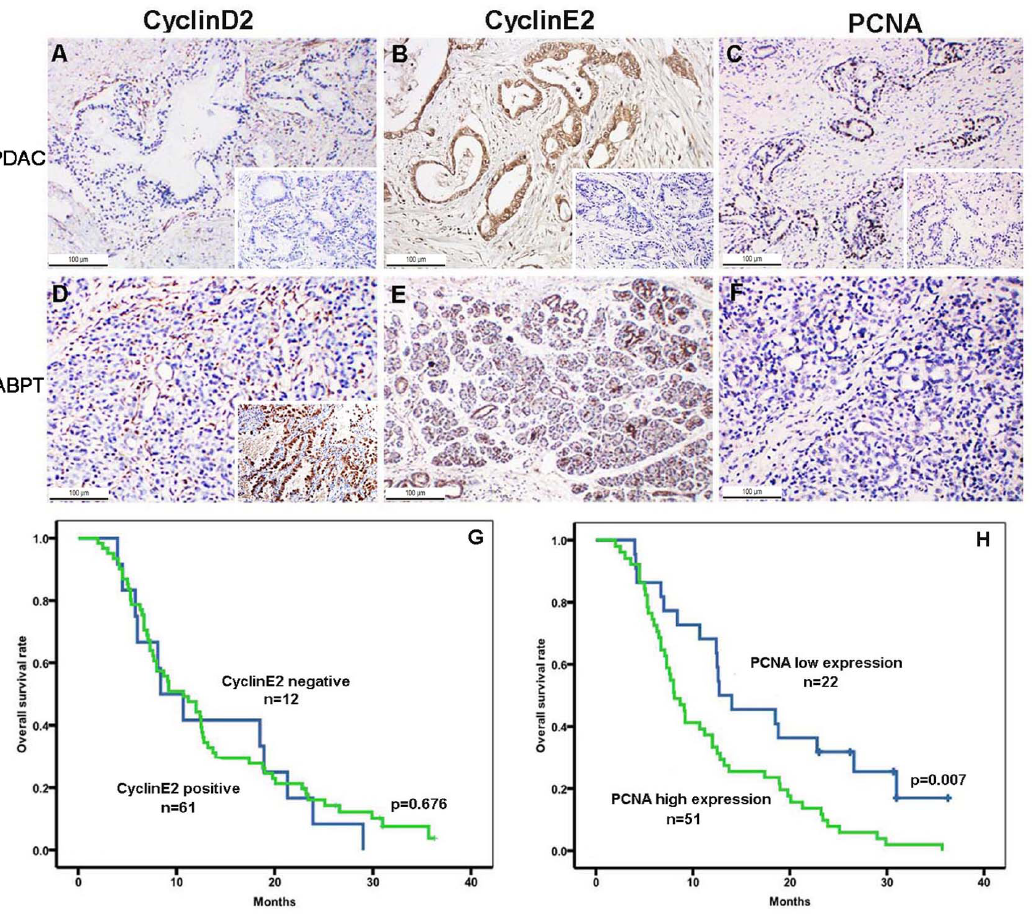
Figure 2. Immunohistochemical expression of cyclin D2, cyclin E2, and PCNA in PDAC tissues as well as overall survival. The PDAC tumor tissues (PDAC) were negative for cyclin D2 (A) and strongly positive for cyclin E2 (B), with a high PCNA proliferative index (C). The adjacent benign pancreatic tissues (ABPT) were negative for cyclin D2 was (D), and positive for cyclin E2, as observed in the ductal epithelial cells of ABPT (E). PCNA was very low in normal pancreatic tissues (F). The insets of A, B, and C show the negative controls. The inset in D indicates that cyclin D2 is a positive control of lung adenocarcinoma. Original magnification, 200 6 . Overall survival after resection of pancreatic cancer with the cyclinE2-positive versus cyclinE2-negative groups was not significant ( P =0.676) (G), whereas overall survival after resection of pancreatic cancer with the PCNA high proliferative index versus PCNA low proliferative index groups had a significantly shorter survival ( P =0.007) (H). doi:10.1371/journal.pone.0076450.g002 PLOS ONE |